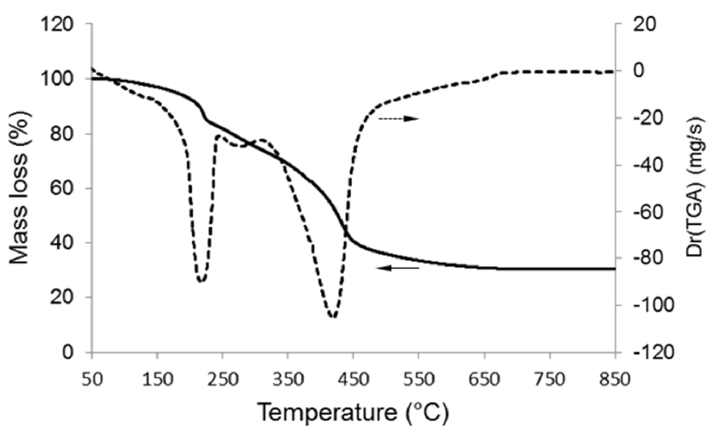
Figure 1. Thermogravimetric analysis (TGA) of the gel corresponding to the 80SiO 2 -20CaO (mol.%) nominal composition: mass loss and lass loss derivative.